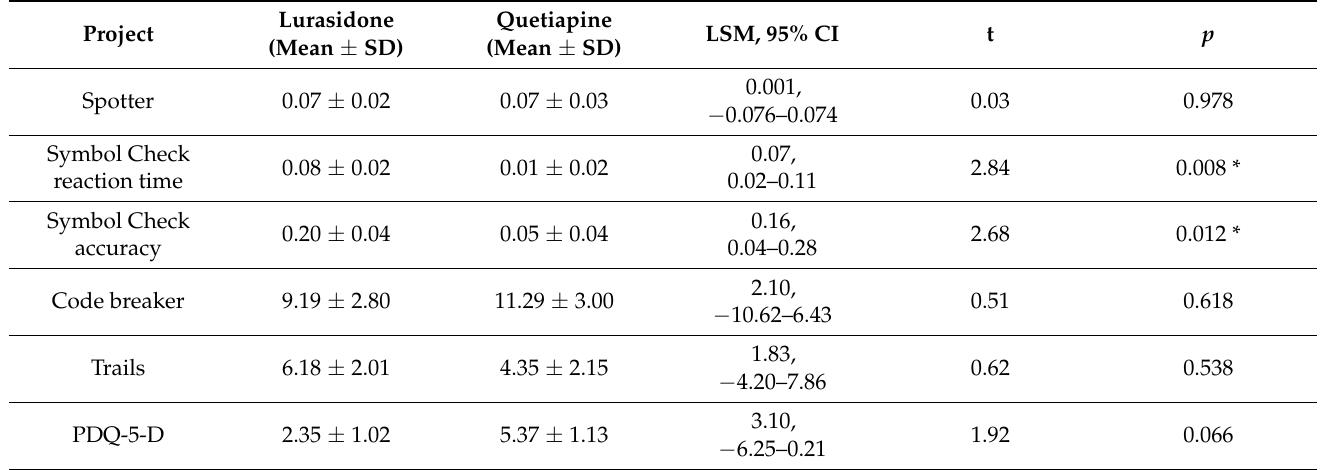
Table 2. Comparison of the change in cognitive function between the two groups before and after